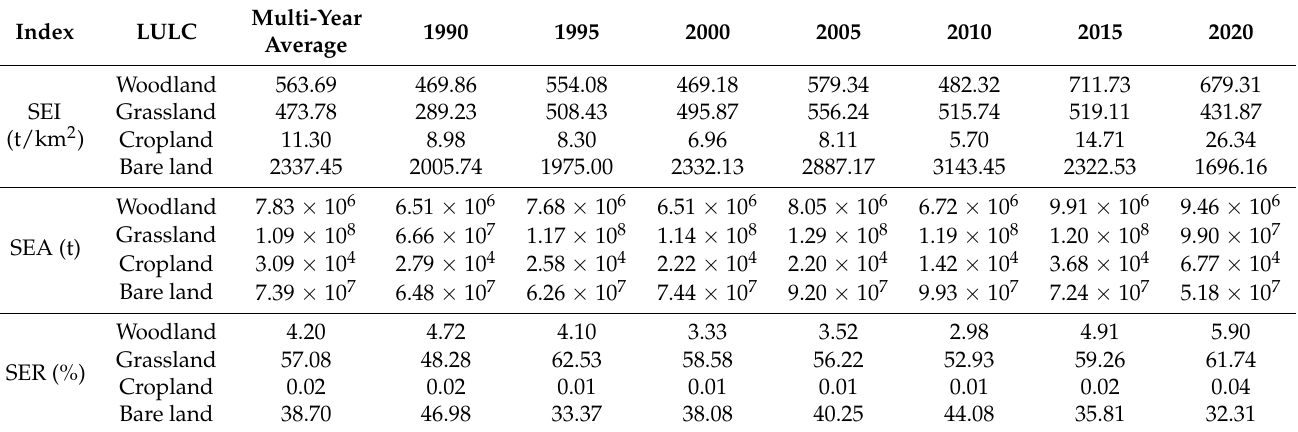
Table 6. SEI, SEA, and SER of LU